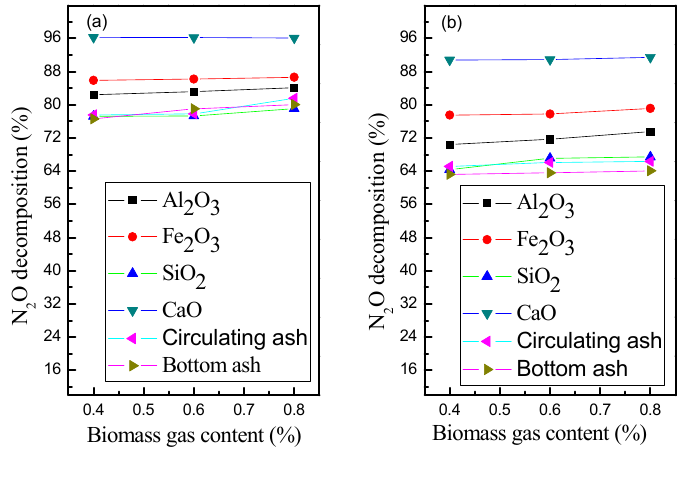
Figure 10. Influence of biomass gas on heterogenous N content was 5%: ( a ) N of 10